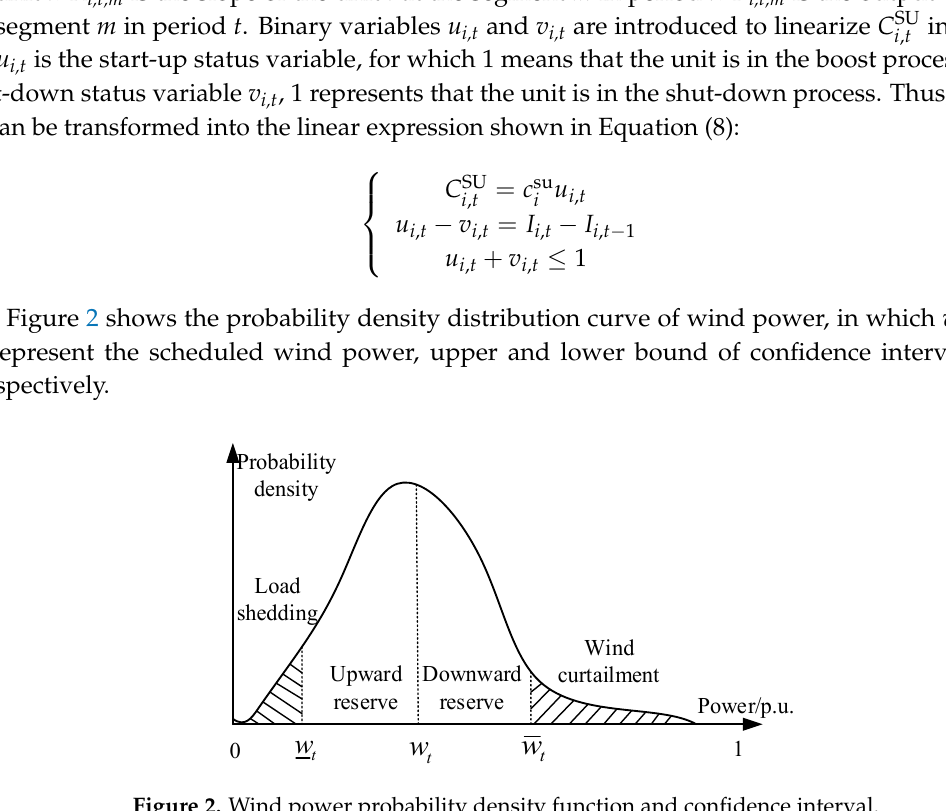
Figure 2. Wind power probability density function and confidence interval.